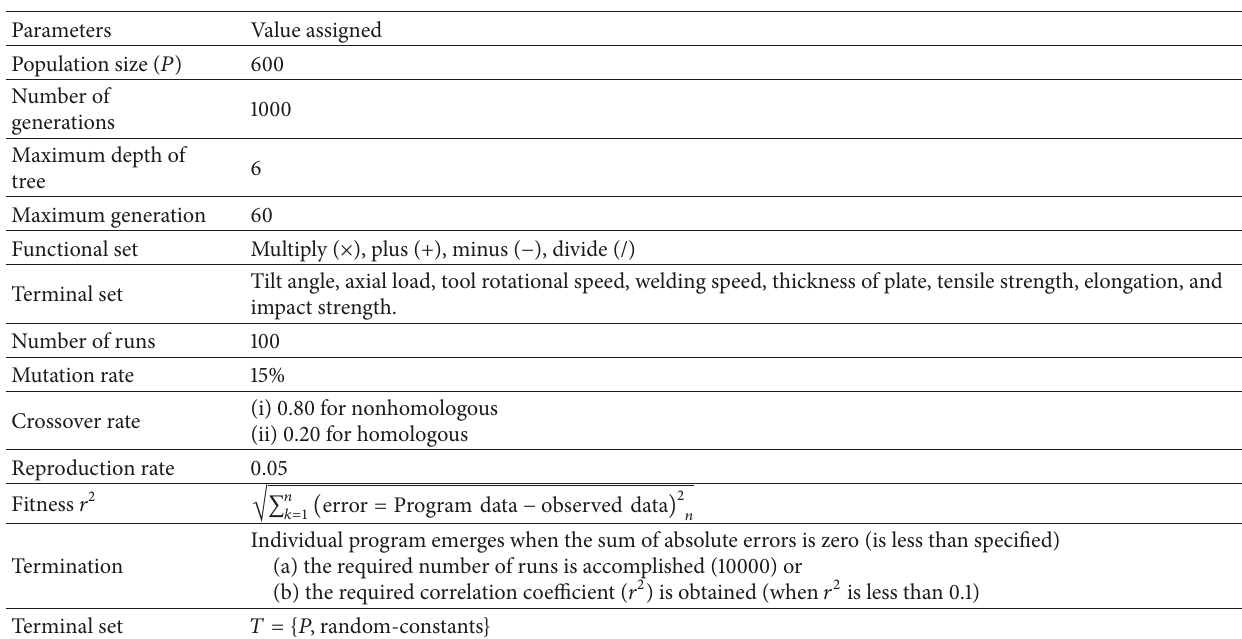
Table 3: Parameter setting for genetic